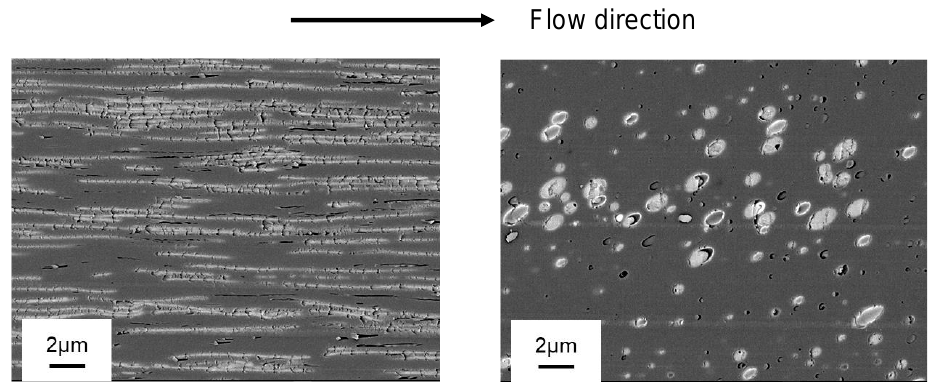
Figure 7. SEM images in an injection-molded product of PC/LDPE (95/5); the ( left ) shows the skin region, and the ( right ) shows the core region. The arrow indicates the flow direction.